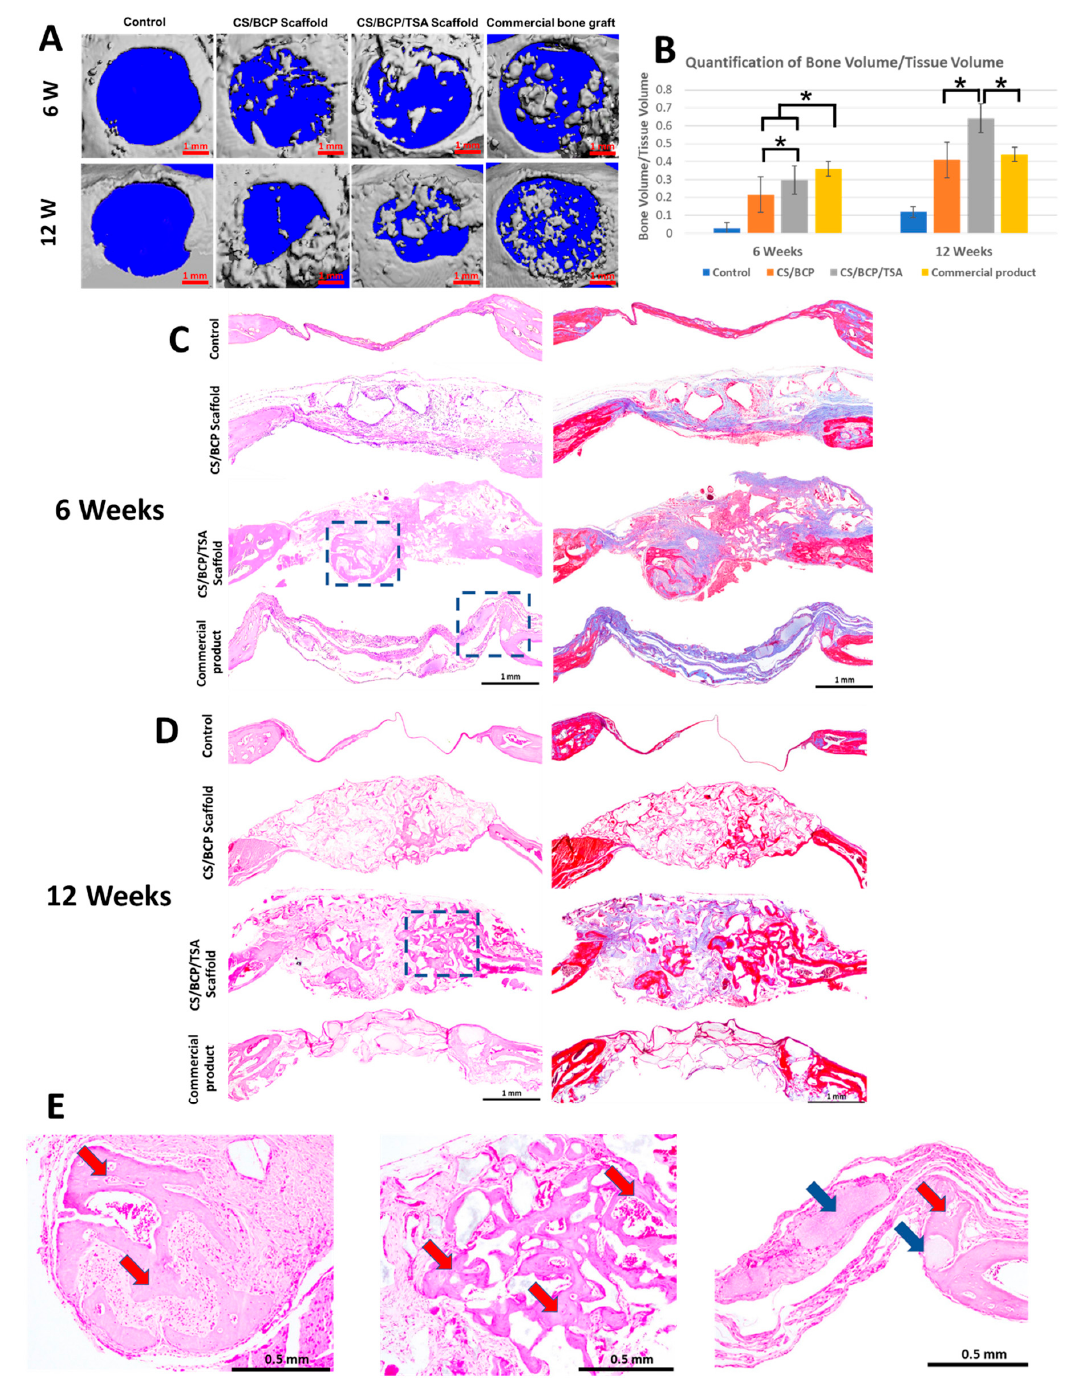
Figure 7. In vivo bone regeneration potential of CS/BCP/TSA scaffolds. ( A ) Micro-CT-based 3D images of new bone formation (Scale bar—1 mm). ( B ) Quantification of BV/TV of CS/BCP/TSA scaffolds, compared with CS/BCP without TSA loading and commercial bone graft product at 6 and 12 weeks after implantation. ( C , D ) By H&E and Masson’s trichrome staining, histological view of defects implanted with scaffold at 6 and 12 weeks after implantation, low magnification (4×), scale bar—1 mm. ( E ) High magnification (40×), from left to right panels, showing the trabecular bone ingrowth in CS/BCP/TSA scaffolds both 6 and 12 weeks (red arrows), while commercial graft group remains incompleted BCP resorption (blue arrows), scale bar—0.5 mm, * p < 0 . 05 .